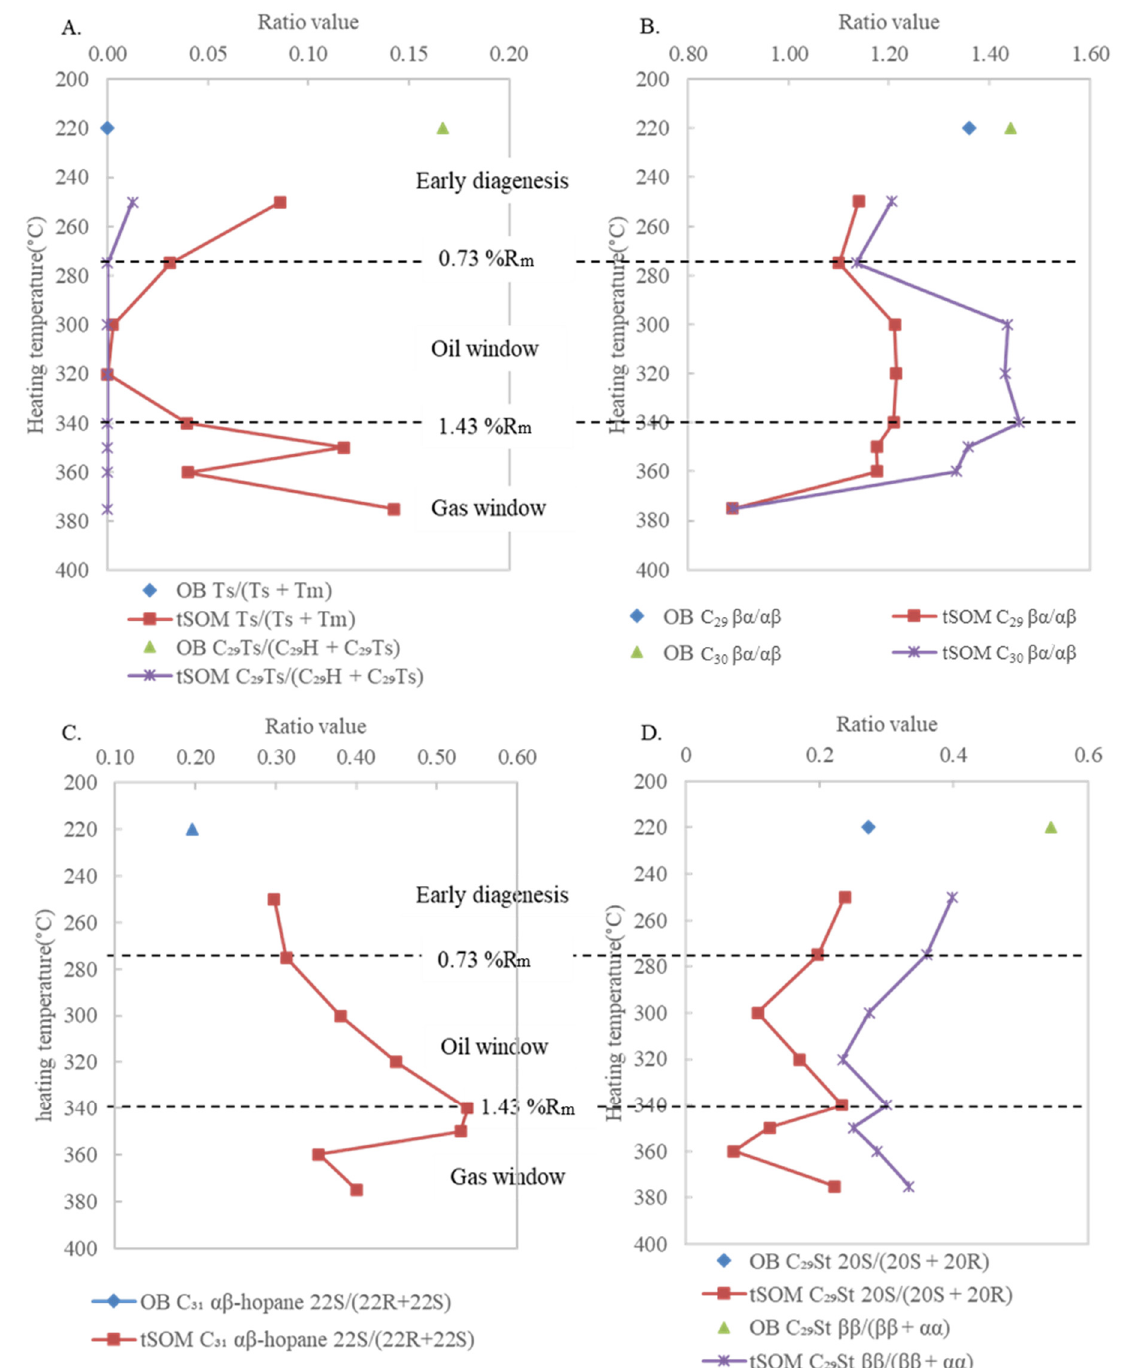
Figure 6. Changes in hopane and sterane maturity ratios in the OB and the tSOMs generated under different target temperatures (own elaboration). Each data dot on subfigure ( A – D ) represents ratio value in either the original bitumen (OB) or the total soluble organic material (tSOM), e.g., OB Ts/(Ts + Tm) referring to the Ts/(Ts + Tm) ratio value generated in the original bitumen. The OB was assigned a heating temperature of 220 °C for visualization purpose only. C 29 βα / αβ = C 29 βα -moretane/C 29 αβ -hopane; C 30 βα / αβ = C 30 βα -moretane/C 30 αβ -hopane. See Figure 4 and Table 1 for peak identification and ratio